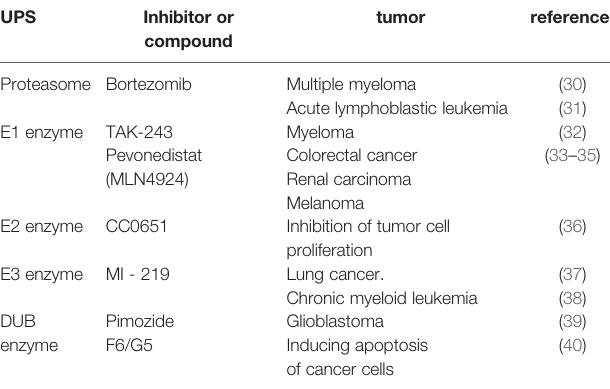
TABLE 1 | Summary of targeted ubiquitin proteasome system therapy. UPS Inhibitor or